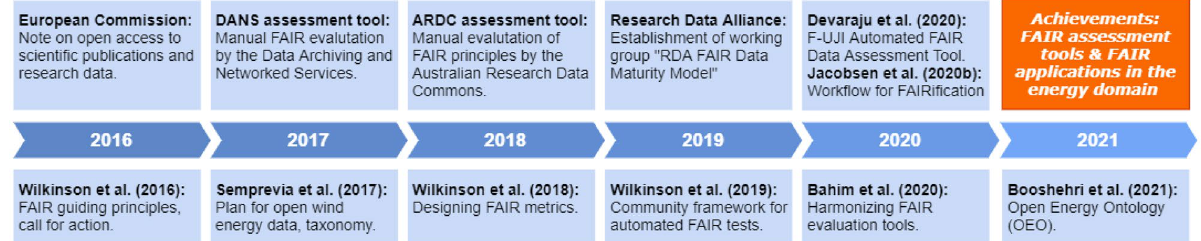
Figure 1. Selected milestones toward the implementation and testing of FAIR guiding principles along with efforts undertaken in the energy domain.